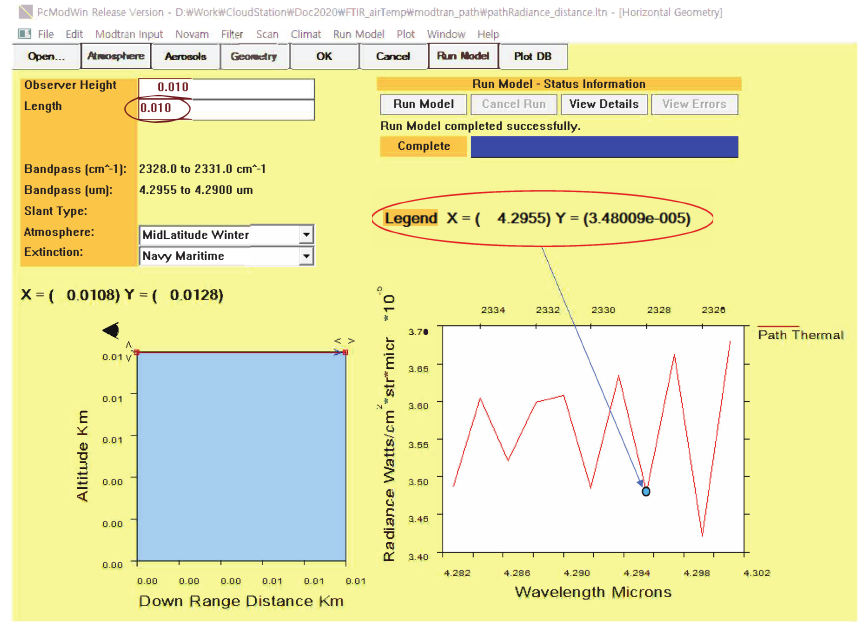
Figure 6. MODTRAN simulation environment for path thermal